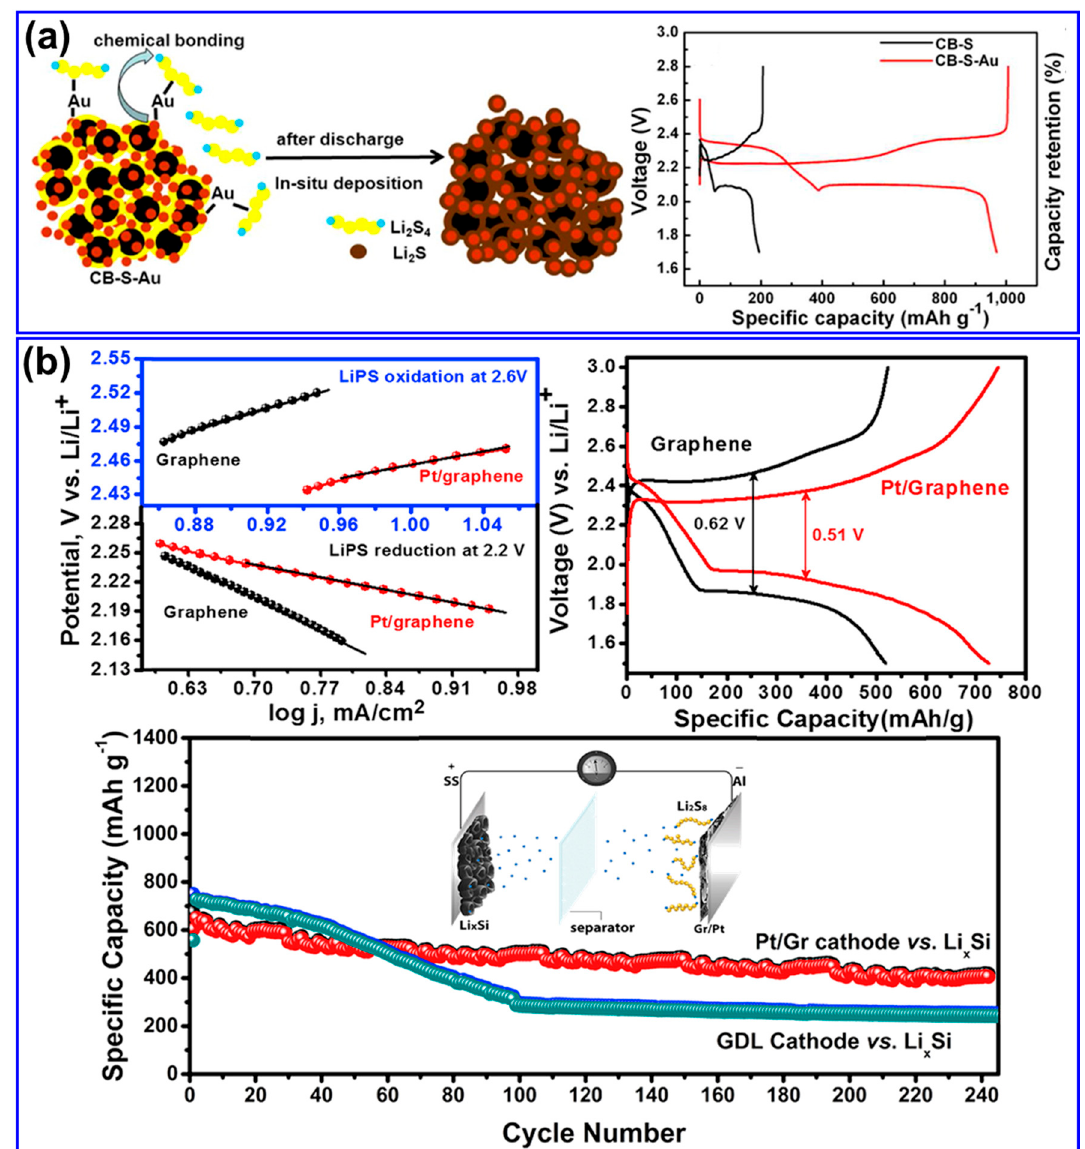
Figure 3. ( a ) Left: Representation of the functioning mechanism of CB-S-Au cathode. Right: Self-discharge behavior represented by initial charge–discharge profiles of CB-S and CB-S-Au electrodes after storing the cells for 400 hrs. Reproduced with permission, Copyright, 2015, American Chemical Society [69]. ( b ) Top: Tafel analysis ( η vs. log j mA cm − 2 ) on LiPS redox reactions and galvanostatic charge–discharge profiles recorded on pristine graphene and Pt/graphene electrodes. Bottom: Cycling behavior of Li-ion polysulfide battery at 0.5 C rate. Reproduced with permission, Copyright, 2019, Elsevier [70] .